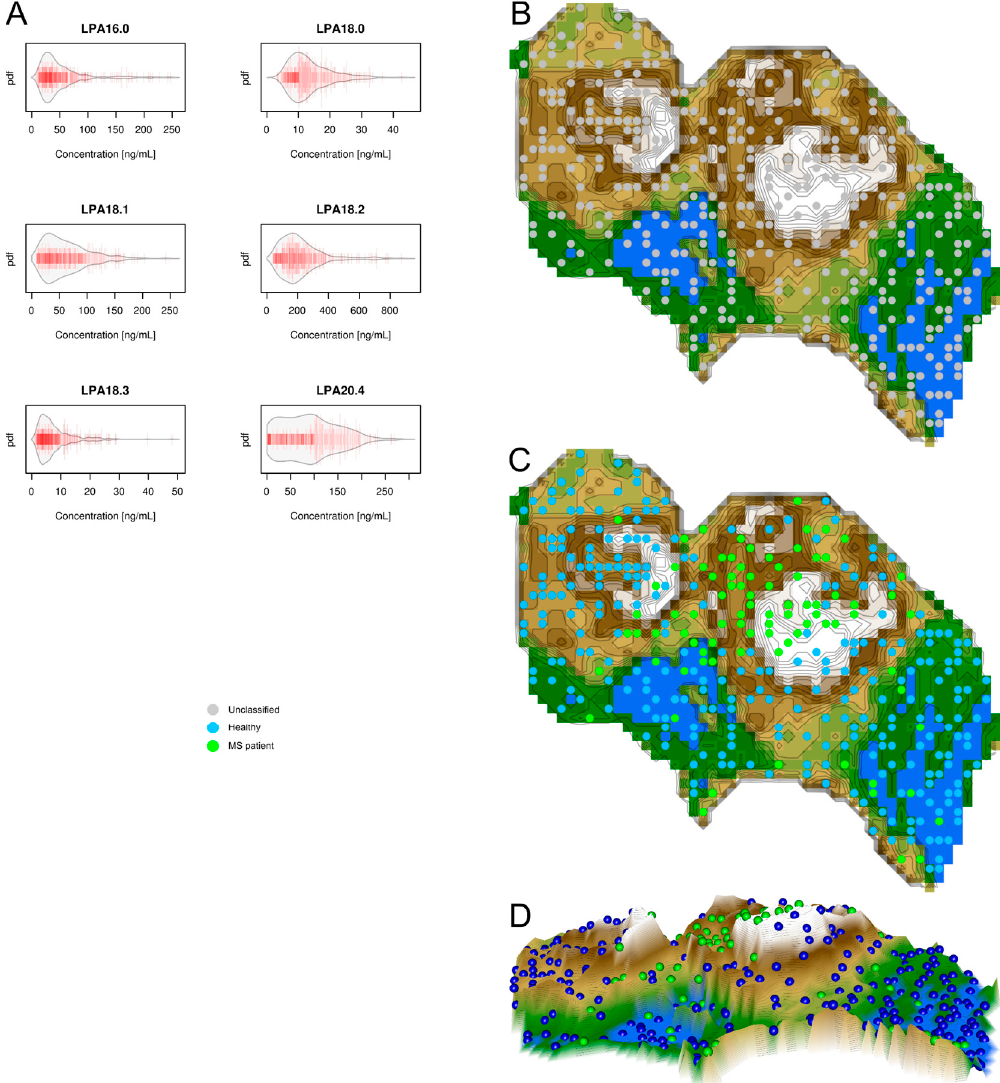
Figure 4. Data structures of lysophosphatidic acid serum concentrations: Left part, ( A ) Serum concentrations of d = 6 lysophosphatidic acids (raw data, complete cohort). The data are shown in alphabetical order of lipid mediator names. The beanplots [13] show the individual observations as small lines in a one-dimensional scatter plot, surrounded by a mirrored kernel density estimation of the distributions. Each panel displays a single lysophosphatidic acid marker. LPA = lysophosphatidic acid. Right part: U*-matrix visualization of distance and density based structures of the lysophosphatidic acid serum concentrations ( d = 6 lysophosphatidic acid markers) observed in n = 102 multiple sclerosis patients and n = 301 healthy subjects. The figure has been obtained using a projection of the data points onto a toroid grid of 1,440 neurons where the opposite edges are connected. The U*-Matrix was colored as a geographical map with brown (up to snow-covered) heights and green valleys with blue lakes. Valleys indicate clusters and watersheds indicate borderlines between different clusters. The dots indicate the so-called "best matching units" (BMUs) of the self-organizing map (SOM), which are those neurons whose weight vectors are most similar to the input. A single neuron can be the BMU for more than one data point or subject, hence, the number of BMUs may not be equal to the number of subjects as in the present case. Differently colored BMUs represent healthy versus MS patient groups; ( B ) Projection of the markers shown in A onto a self- organizing map. On the raw U-matrix, the BMUs are colored neutrally and no real cluster structure